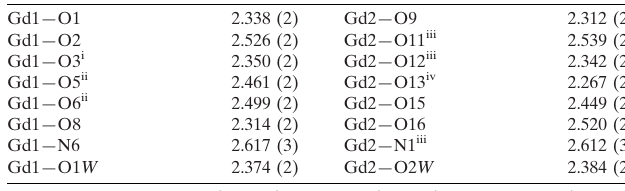
Selected bond lengths (A˚